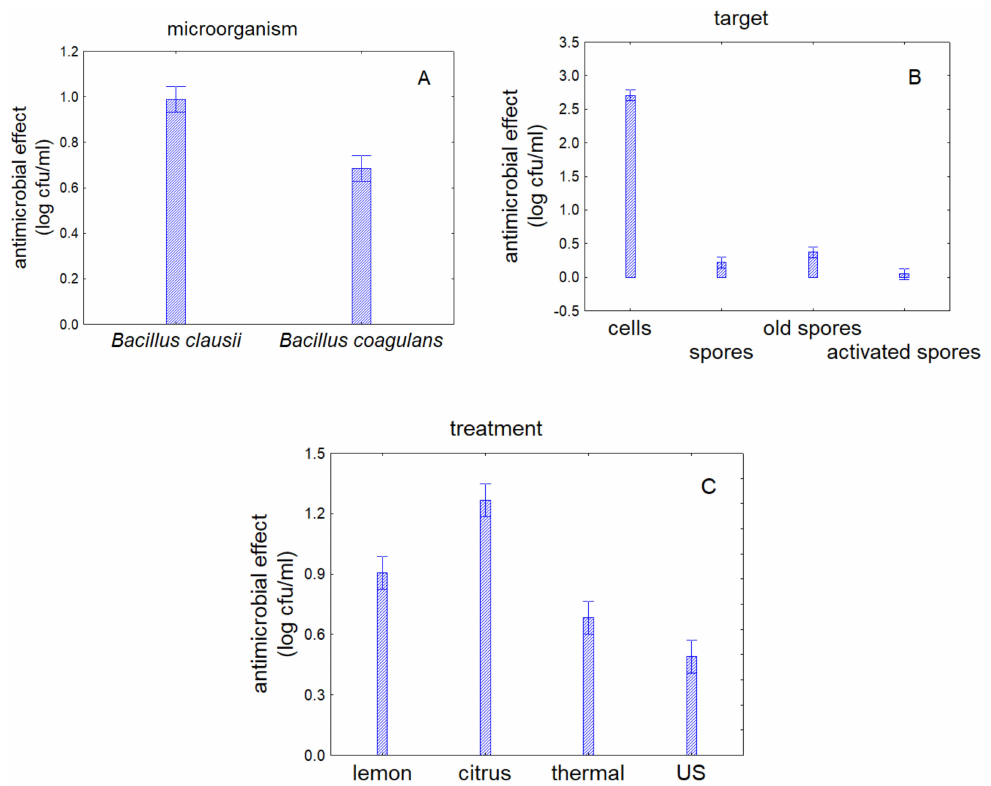
Figure 1. Decomposition of the statistical hypothesis for the e ff ect of individual terms. Bars denote 95% confidence intervals. ( A ) e ff ect of the strain; ( B ) e ff ect of the target; and ( C ) e ff ect of the